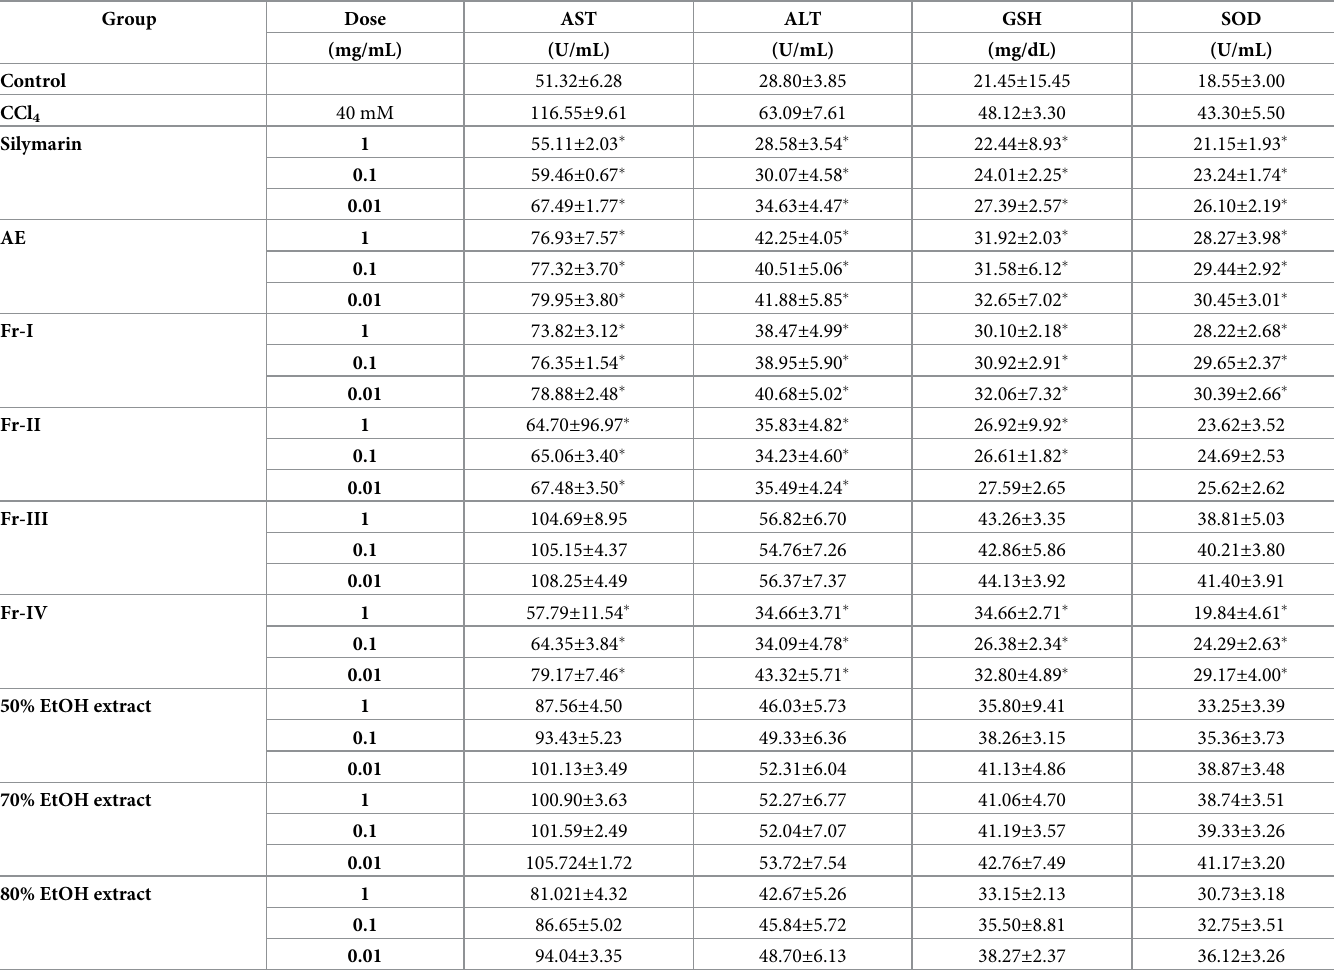
Table 3. Protective effect of different extracts and fractions of P . niruri on CCl 4 induced toxicity in Hepg2 cell line.